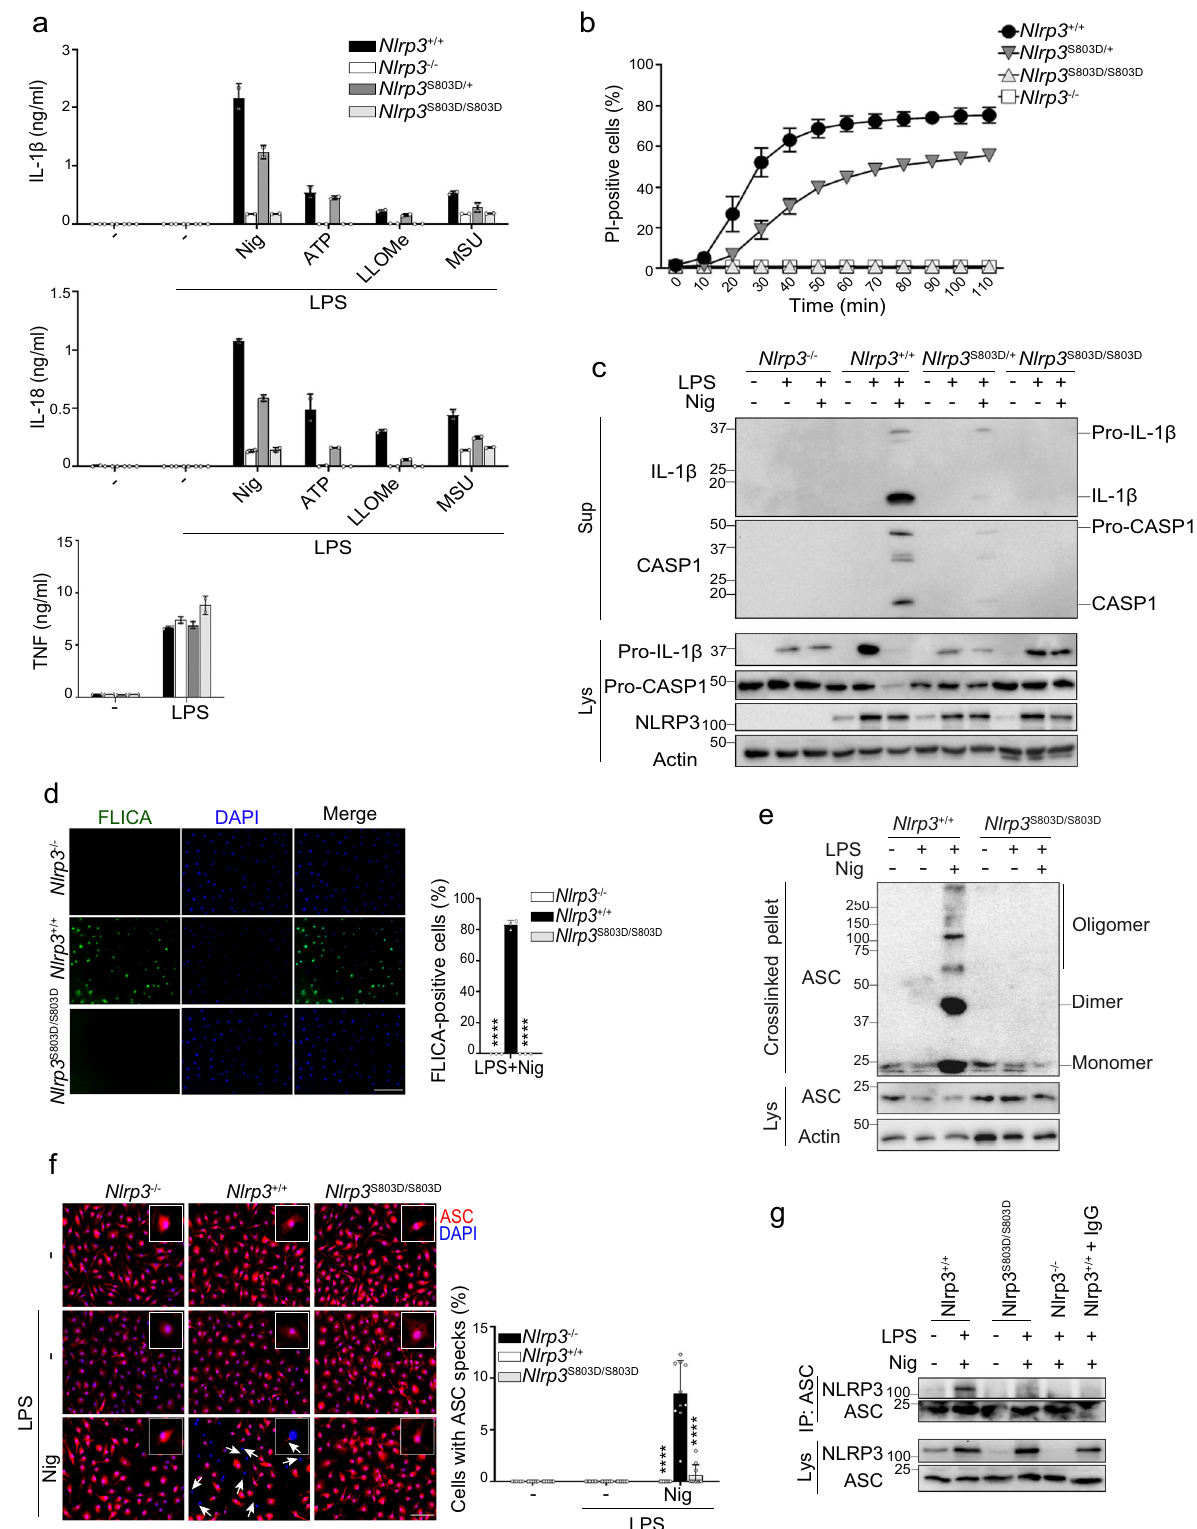
Fig. 6b). As expected, all measured distances in WT NLRP3/ the E864 NLRP3 /H125 NEK7 , D747 NLRP3 /R131 NEK7 and R779 NLRP3 / NEK7 complex were stable or showed only few variations over H125 NEK7 distances over time, while these distances were more stable in the NLRP3 S806A/NEK7 complex. To conclude, our time re fl ecting the stability of the structure, while on the opposite structural models suggested that NLRP3 S806D substitution we observed drastic changes over the time with NEK7 Q129R destabilized NEK7 interaction with NLRP3 LRR domain. mutant. Similarly, NLRP3 S806D showed important variations of NATURE COMMUNICATIONS| (2021) 12:5862